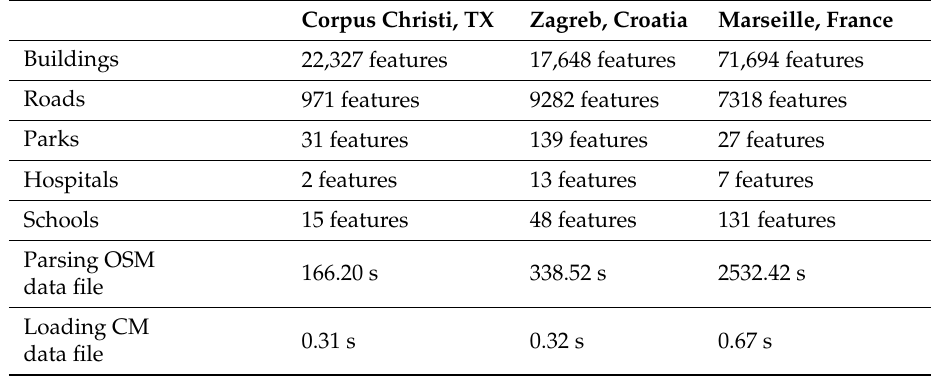
Table 1. Performance comparison of parsing and viewing three different cities and their embedded features.